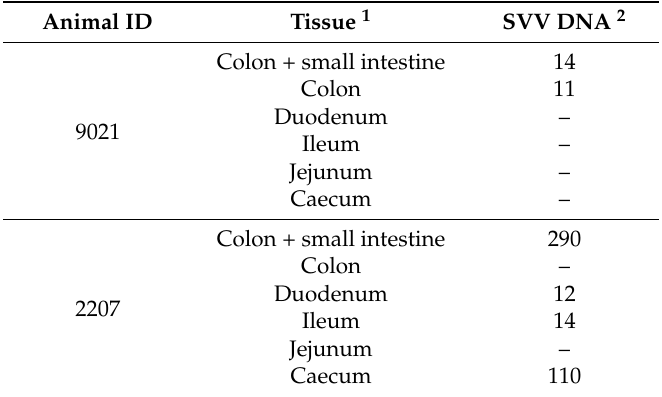
Table 2. Detection of simian varicella virus DNA in intestine of latently infected rhesus macaques. Animal